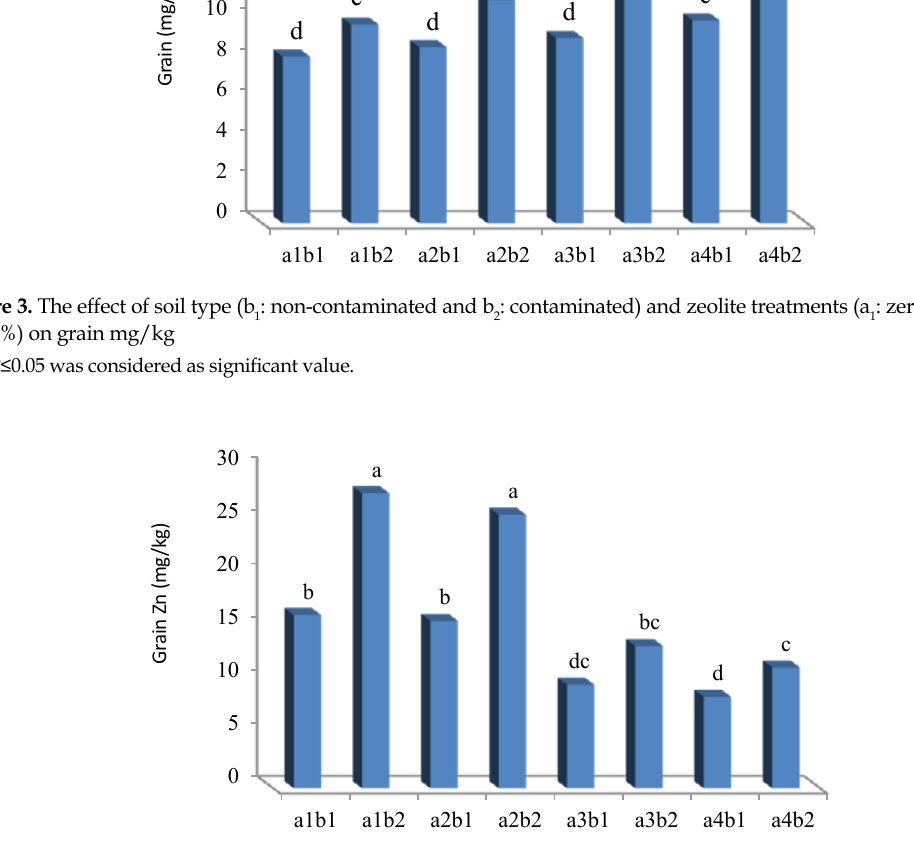
: non-contaminated and b 1